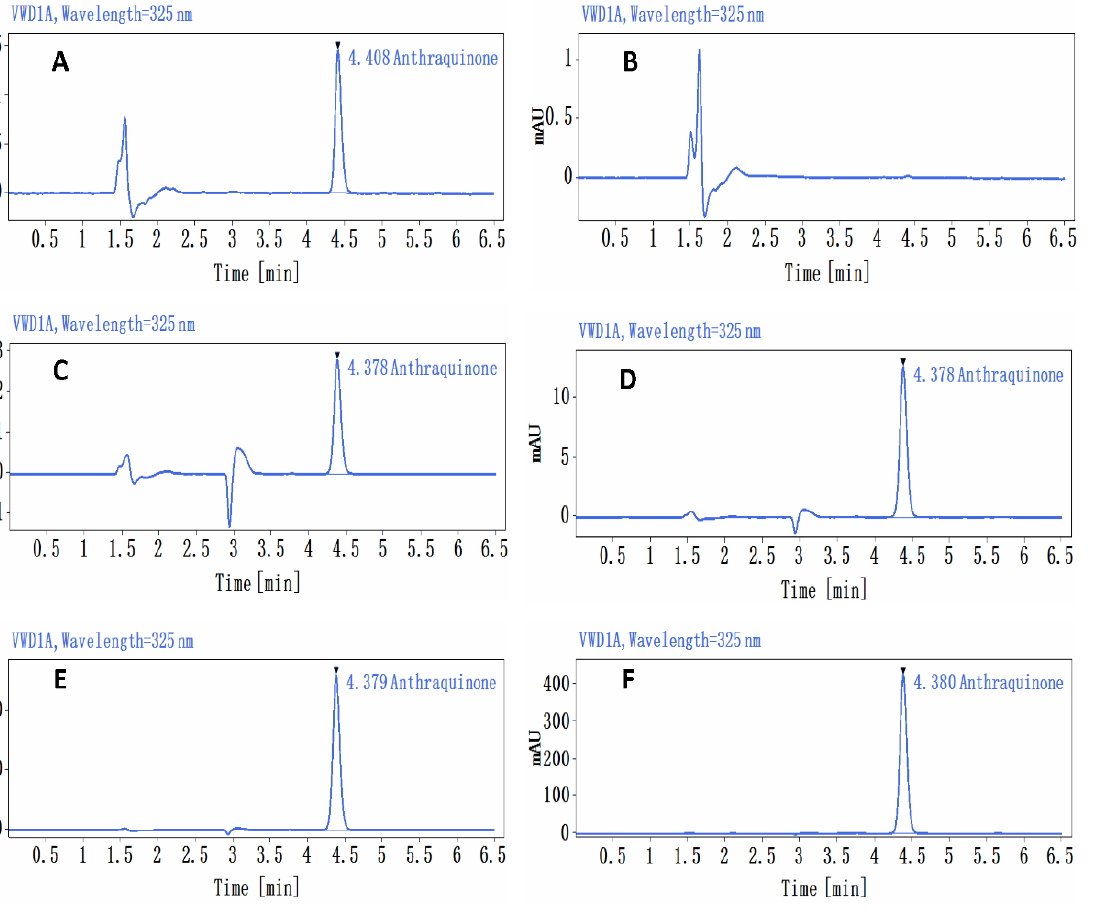
Figure 1. Chromatogram of the analysis of the anthraquinone preparations. ( A ) Standard curve sam- ple (0.5 μ g/mL) chromatogram, ( B ) control solvent 1% CMC-Na chromatogram, ( C ) anthraquinone preparation (0.136 mg/mL) chromatogram, ( D ) anthraquinone preparation (0.544 mg/mL) chro- matogram, ( E ) anthraquinone preparation (2.176 mg/mL) chromatogram, ( F ) anthraquinone prepara- tion (17.408 mg/mL)